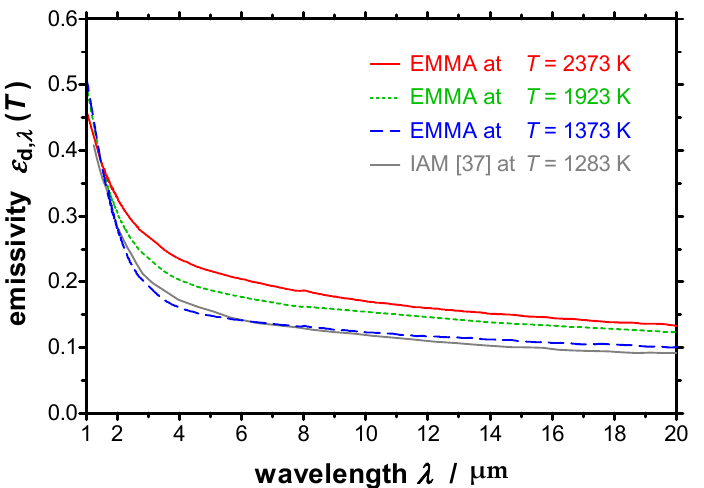
(IAM) at the University of Duisburg-Essen at a temperature of T = 1283 K [37] is additionally plotted in Figure 17. It can be seen that the emissivity derived at IAM is in a good agreement with the emissivity measured with the EMMA at a similar temperature.